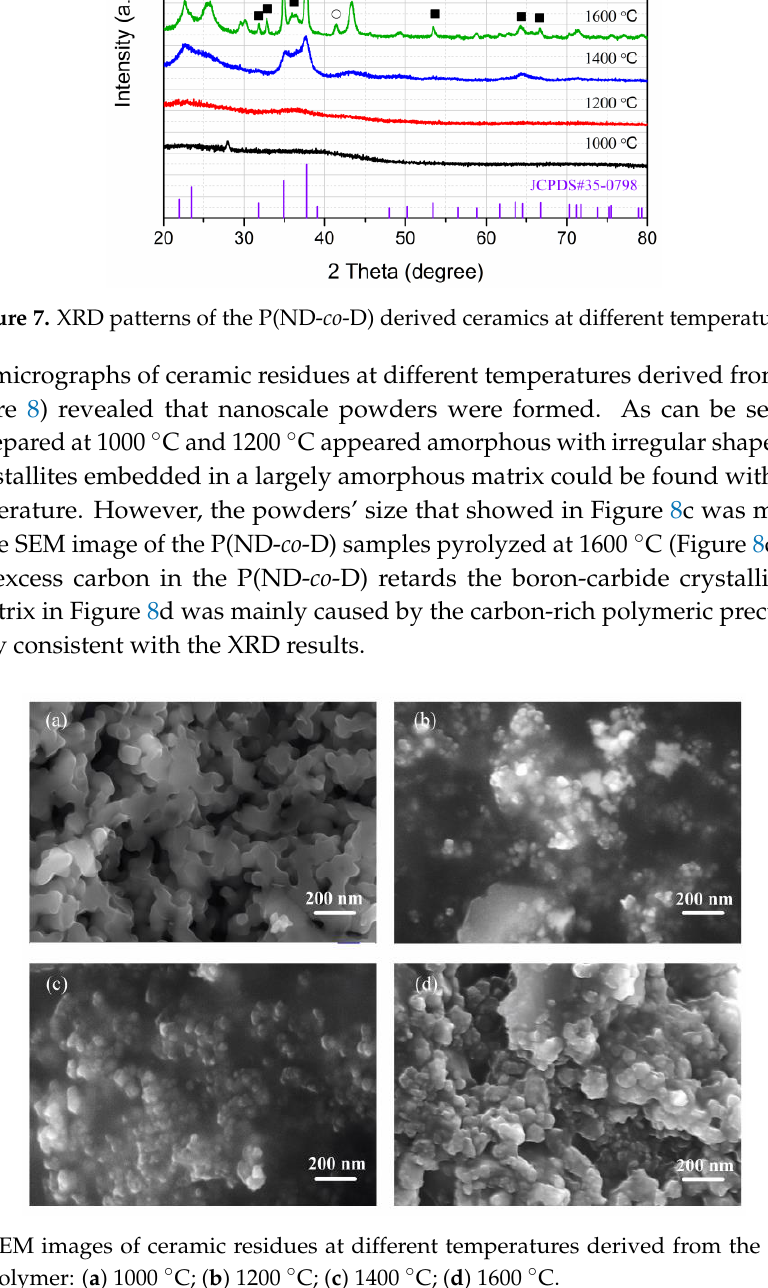
Figure 8. SEM images of ceramic residues at different temperatures derived from the P(ND- co -D) precursor polymer: ( a ) 1000 °C; ( b ) 1200 °C; ( c ) 1400 °C; ( d ) 1600 °C.